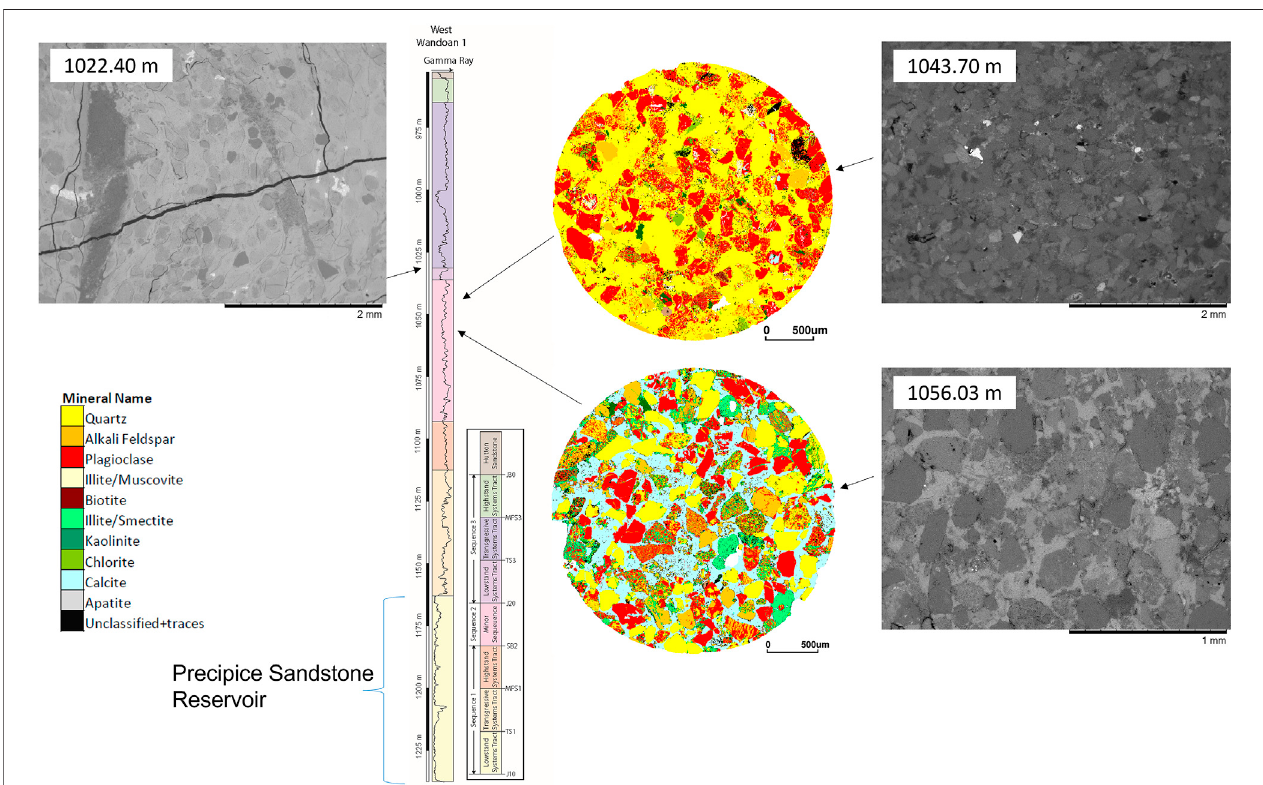
FIGURE 2 | SEM and QEMSCAN images of the Evergreen Formation samples with the QEMSCAN legend. The West Wandoan 1 well gamma ray log is shown for the Precipice Sandstone reservoir and overlying Evergreen Formation. Immediately overlying the Precipice Sandstone is a transition zone region, and above that are the seals of the Evergreen Formation. The sequence stratigraphy and nomenclature are based on the UQ-SDAAP modi fi ed from (La Croix et al., 2020b). See also the log given in the Supplementary Material .